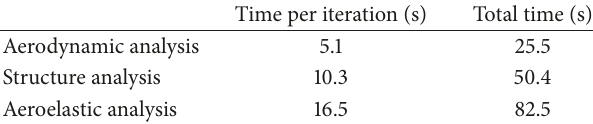
Table 2: The cost time of the aeroelastic